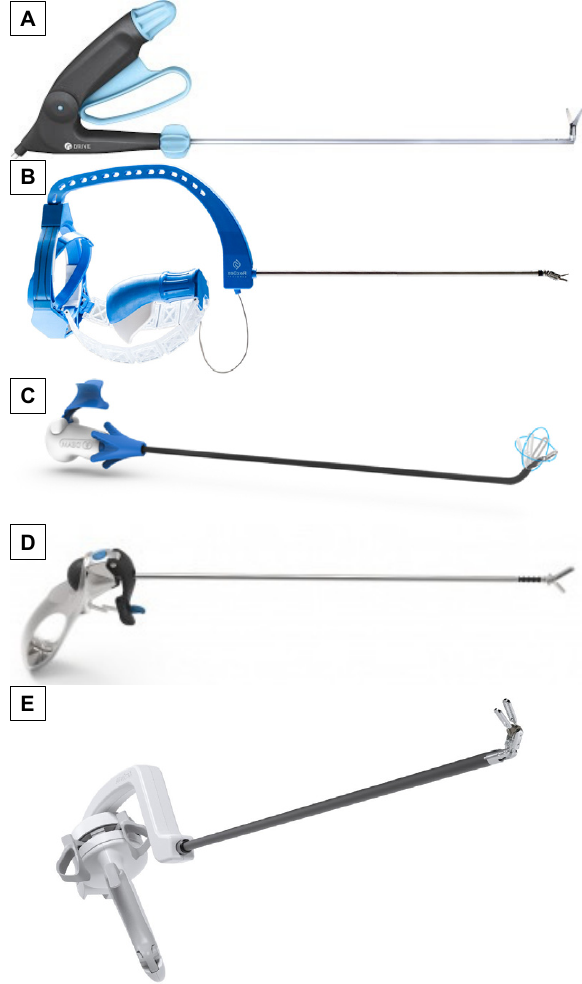
Figure 3. Most commonly available and updated wrist-like devices. ( A ) Radius Surgical System ® (Tuebingen Scientific), ( B ) FlexDex ® (FlexDex Surgical Inc.), ( C ) LaproFlex ® (DEAM), ( D ) Intuitool ® (UneMed), ( E ) ArtiSential ® (LIVSMED).